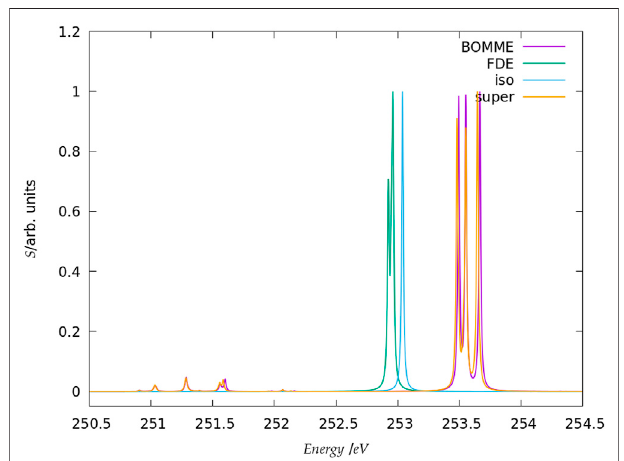
FIGURE 5 | Simulated L 1 -edge spectra for the fl uoride model system in theedgeregion(contrarytotheKedge,nopeaksofappreciableintensityhave been observed at higher energies). It should be noted that here the peak heights (in arbitrary units) for each family of models: free ion (=iso), FDE, BOMME, and supermolecule (super) have been scaled, with a height of 1 assigned to the most intense transition.